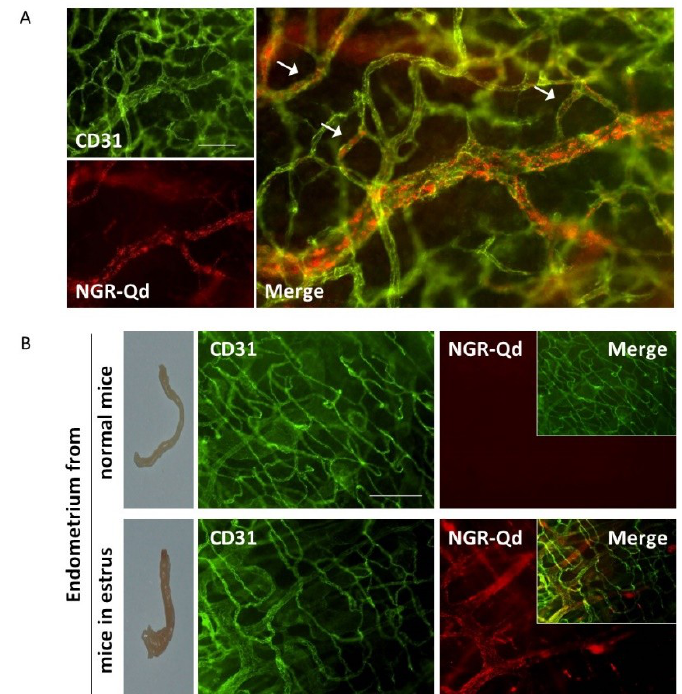
Figure 4. In vivo characterization of the binding properties of the CNGRC peptide. ( A ) In vivo- administered NGR-Qd into CT26 tumor-bearing mice specifically binds to tumor associated vessels. NGR-Qd (red) co-localizes onto tumor blood vessels of a murine colon carcinoma, stained by anti-CD31 Ab (green). Arrows show the staining of smaller vessels. Whole-mount histology with scale bar, 100 µ m. ( B ) NGR-Qd (red) binds to the angiogenic endometrium from mice in estrus (lower panels) but not to the endometrium from mice not in estrus (upper panels). CD31 was used to stain blood vessels (green). Scale Bar, 200 μm.